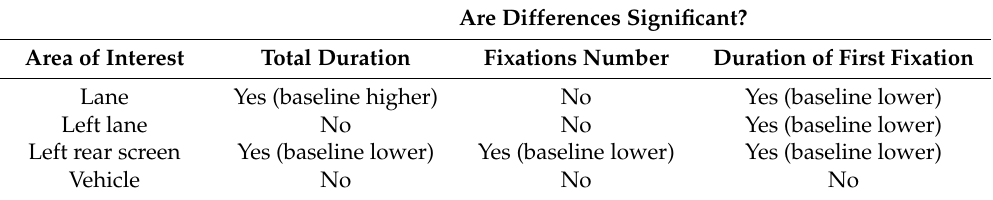
Table 4. Gaze direction comparison during merging manoeuvre with baseline.